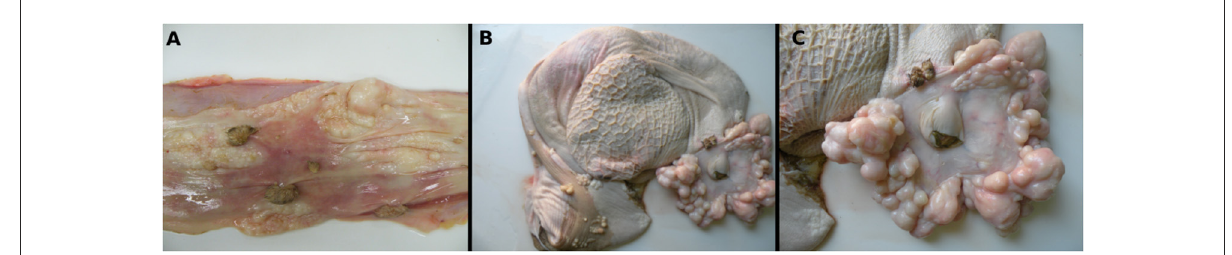
FIGURE1 Macroscopic features of a fibropapilloma and papillomas in the esophagus, rumen, and cardia: (A) esophageal mucosa, multiple pedunculated nodules with a verrucous cauliflower-like appearance, consistent with papillomas, and others with spherical to plaque-like conformation and smooth surface, characterizing fibropapillomas; (B) rumen and reticulum, note in the mucosa of the rumen multifocal spherical and plaque-like nodules with a smooth, shiny white surface, distributed overwhelmingly along the rumen pillars and around the cardia; a single papillomatous nodule can be seen near the cardia; (C) rumen, a closer view of the cardia with numerous nodules with a smooth shiny surface and pearly-white aspect are disposed all around the periphery of the cardia. There is also a single papilloma near to the